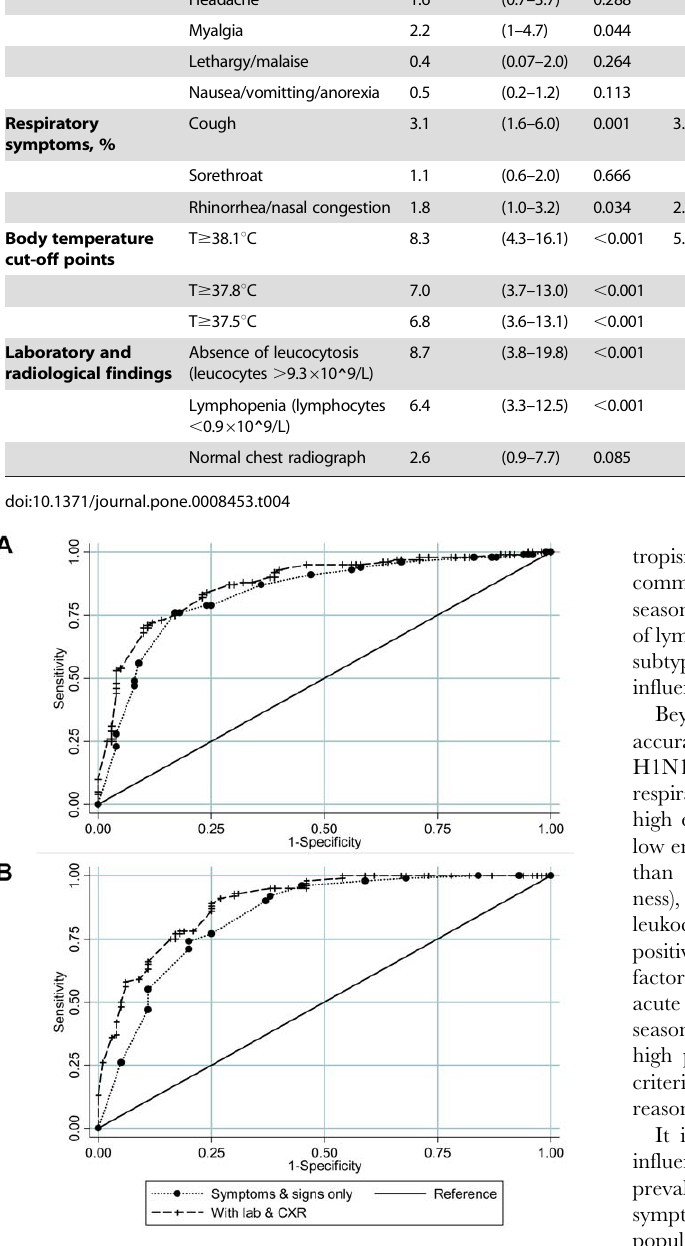
Patient characteristics